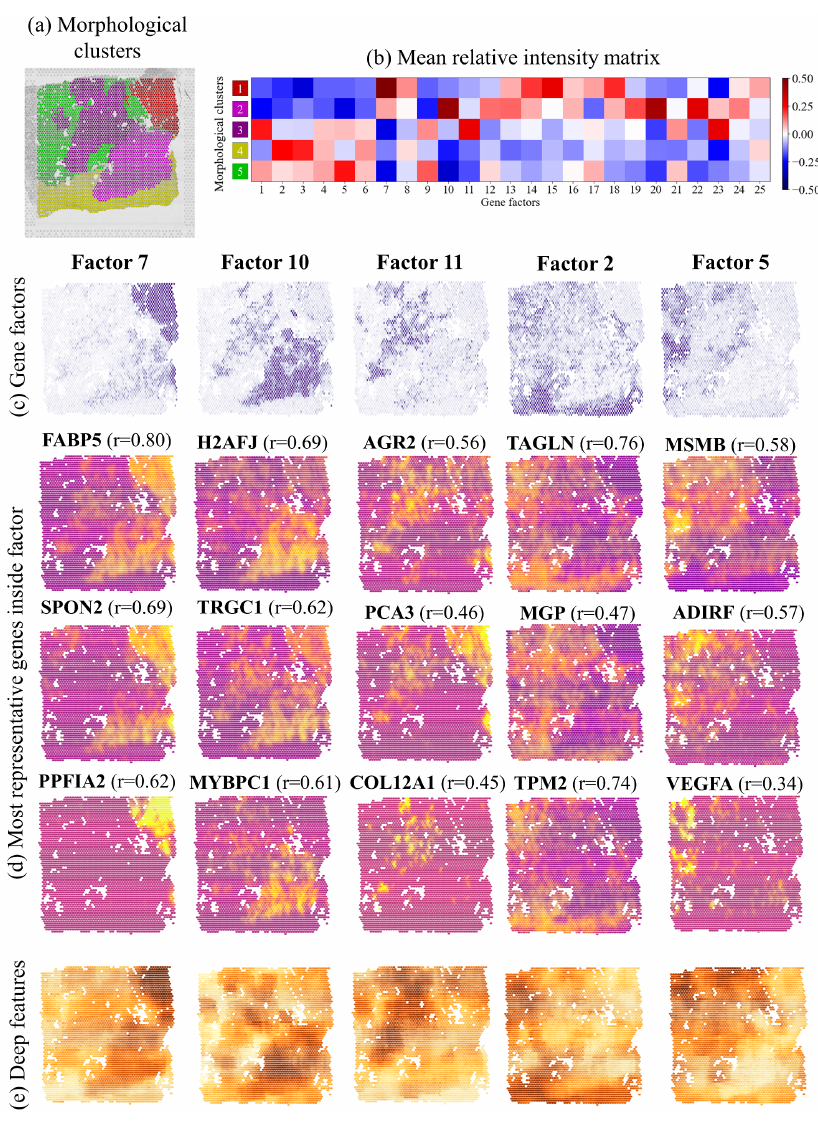
Figure 4. ( a ) Morphological clusters obtained by unsupervised clustering in ten-dimensional feature space for section 5. ( b ) Comparing gene expression factors with morphological clusters identifies the best-matching gene expression factor. ( c ) Visual presentation of the gene expression factors with the highest ratio for each cluster. ( d ) Genes with the largest number of reads for each selected factor (yellow and purple dots represent a large and small number of local reads, respectively). Values in parenthesis are standardized Pearson correlations of the genes with ( e ) the most significant feature of each of the morphological clusters